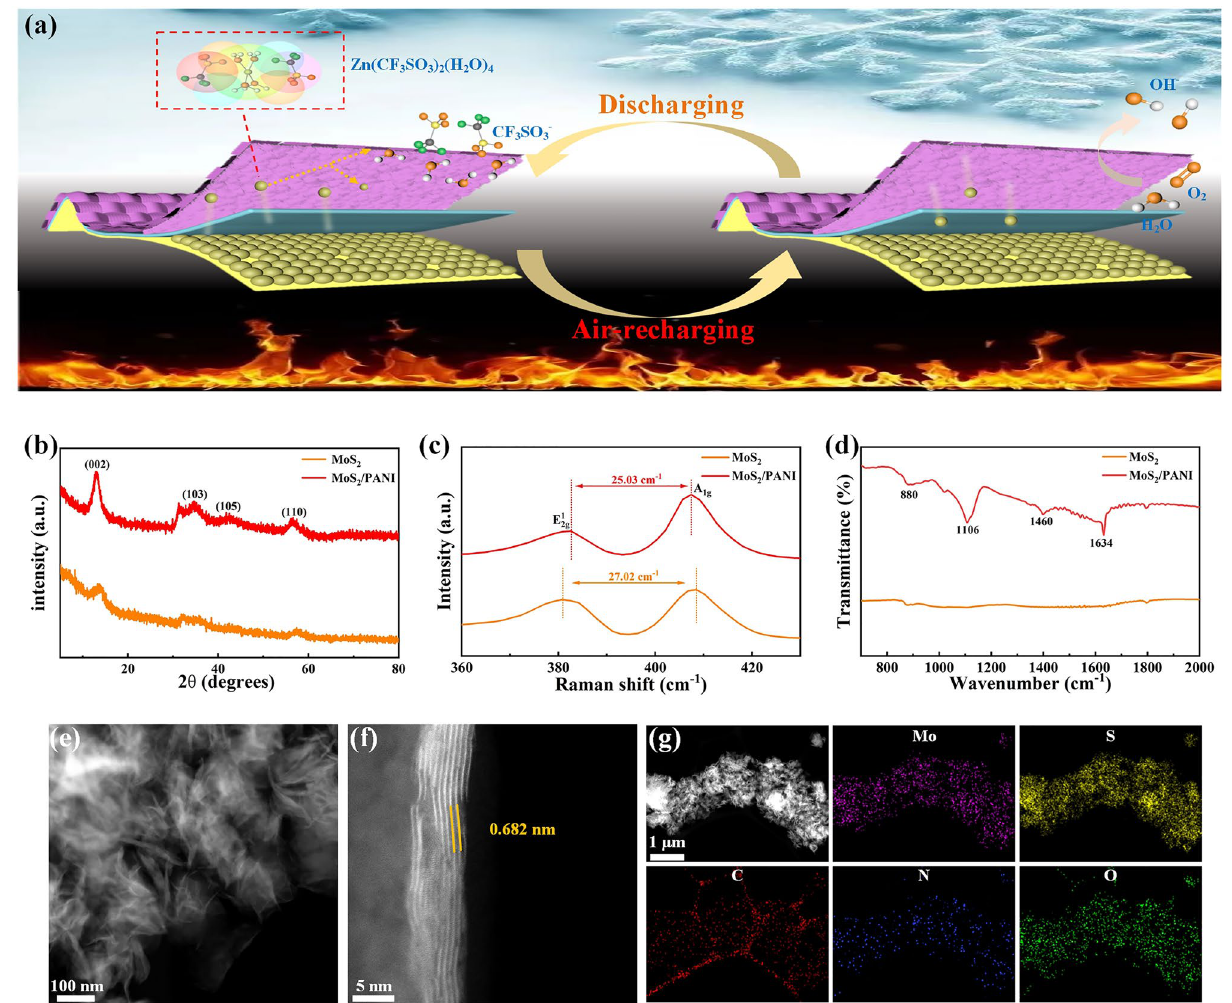
Fig. 1 Structure of air-rechargeable QSZIBs and characterization of MoS 2 /PANI nanoflowers. a Structure of air-rechargeable QSZIBs, b XRD patterns, c Raman patterns and d FTIR spectrum of original MoS 2 and MoS 2 /PANI. e Enlarged TEM image, f HTEM image and g STEM ele- mental mapping image of MoS 2 /PANI